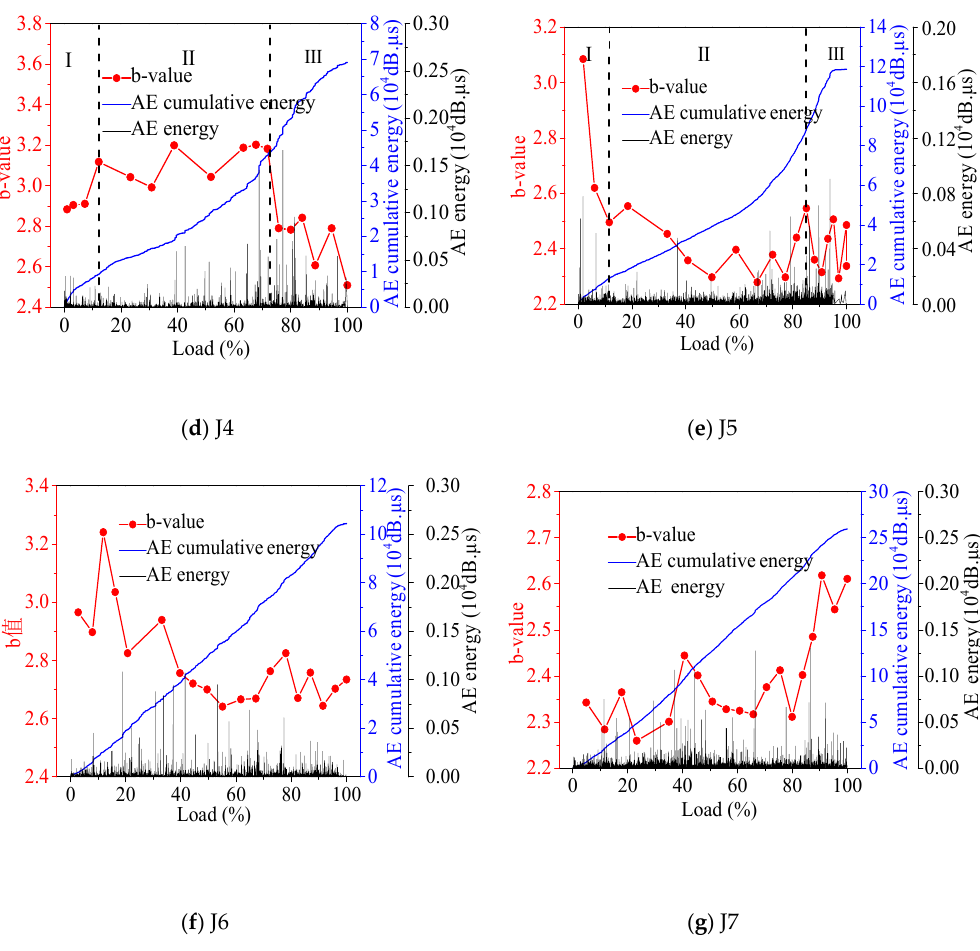
Figure 4. Concrete damage process.